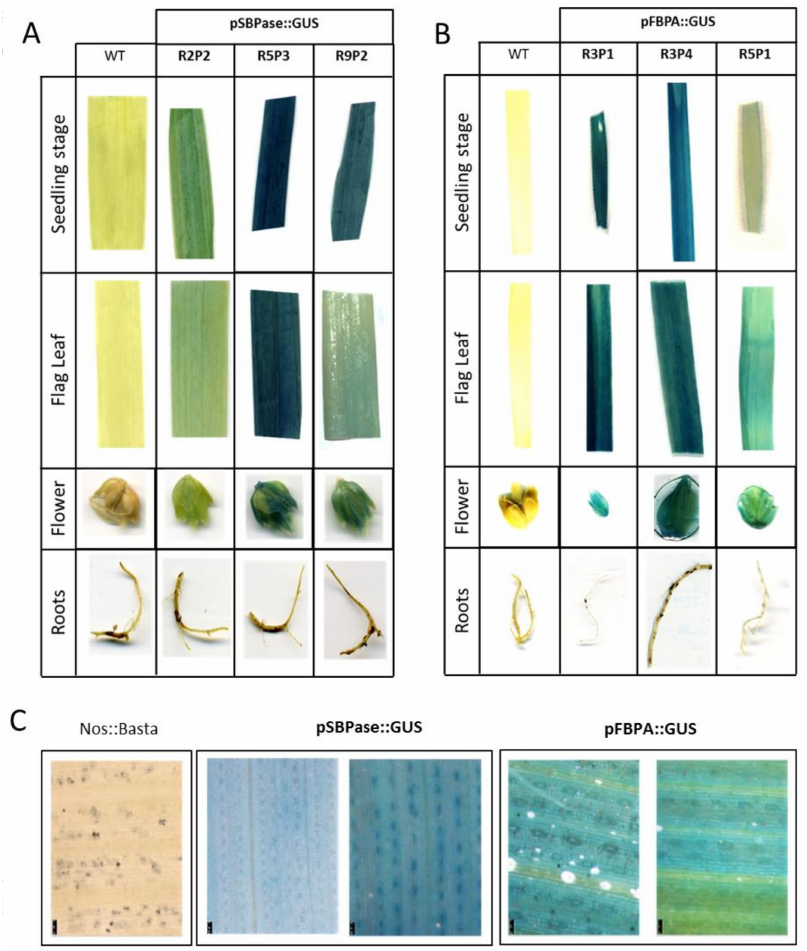
Figure 4. Histochemical analysis of GUS activity in T1 wheat lines stably transformed with the B. distachyon SBPase or FBPA promoter constructs. gus expression driven by ( A ) SBPase promoter and ( B ) FBPA promoter in tissue from young seedlings, from flag leaves of mature plants and in flowers and roots. WT = wild type infiltrated tissue is used as a control. ( C ) Microscopic observation of localization of gus expression in T1 wheat leaves of two independent lines for each construct compared to plants transformed with the bar (Nos:Basta) selectable marker gene construct only